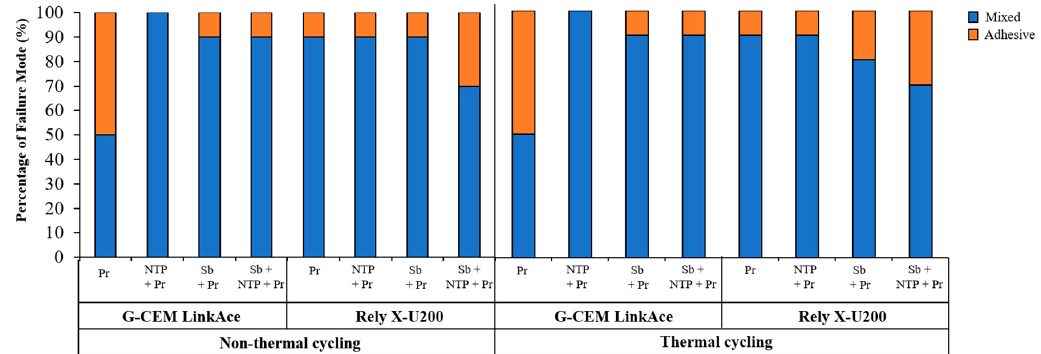
Figure 7. The percentage of failure mode of each group after SBS test. Pr, Zirconia primer; NTP + Pr, NTP + Zirconia primer; Sb + Pr, Sandblasting + Zirconia primer; Sb + NTP + Pr, Sandblasting + NTP + Zirconia primer.